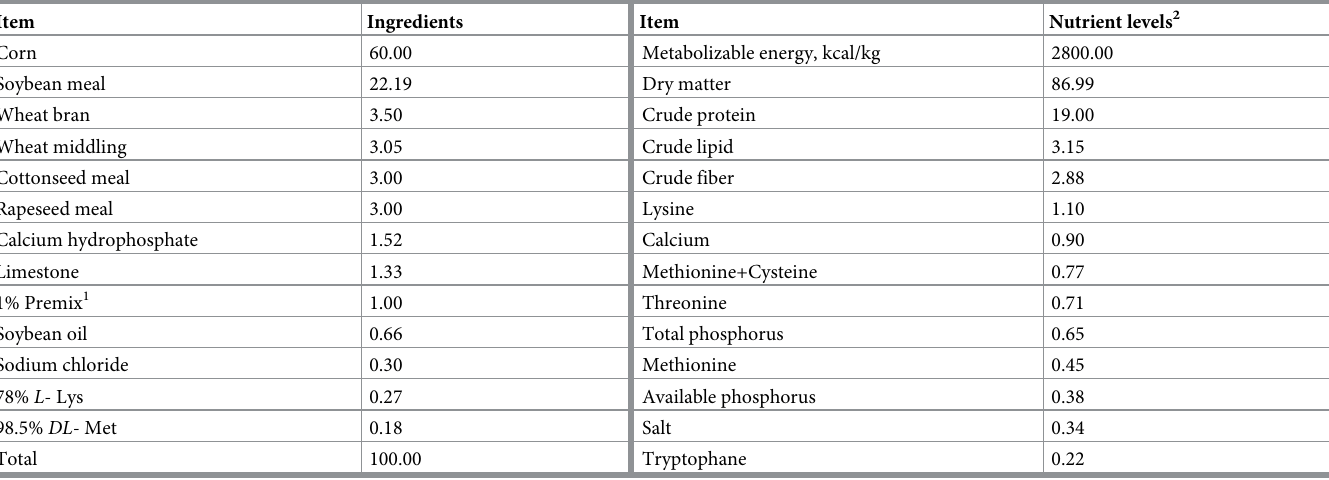
Table 1. Composition and nutrient levels of basal diet (air-dry basis,